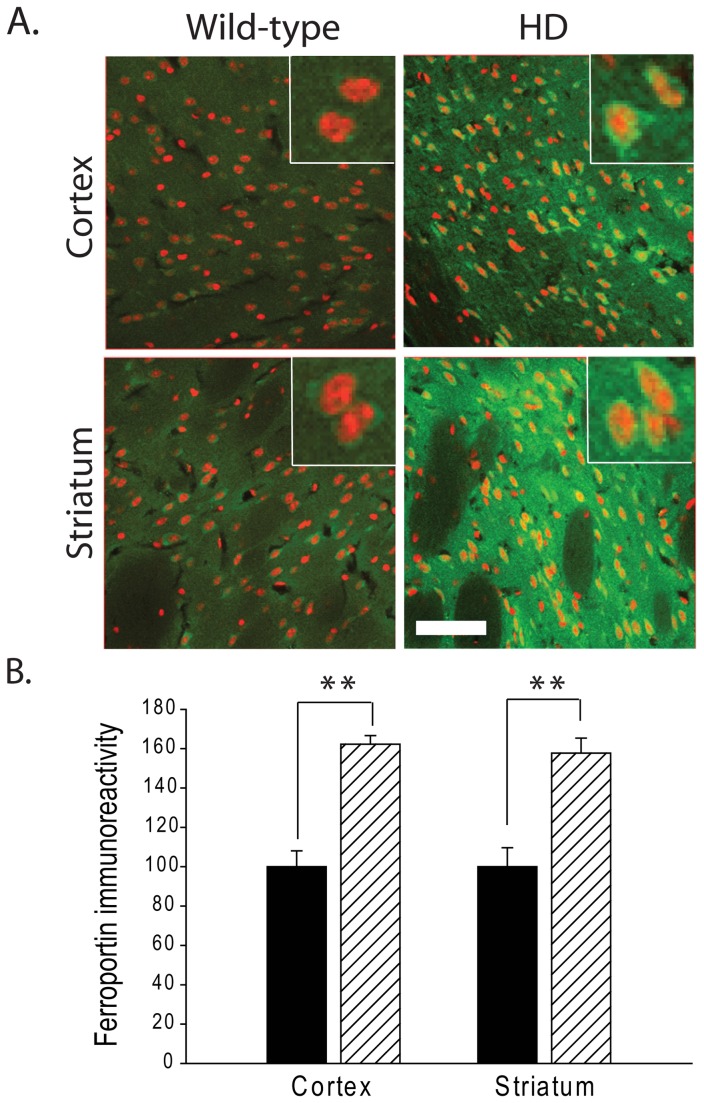
Increased expression of ferroportin (FPN) in R6/2 HD mice.
A. FPN immunoreactivity is increased in HD mouse cortical and striatal neurons as compared to wild-type mice at 12 weeks (red, DRAQ5 stain; green, FPN). Bar = 50 μm. Inserts = 20 μm. B. Quantification of A. FPN immunoreactivity is increased ~0.6 fold in both cortex and striatum of HD mice as compared to WT litter mate mice. P-value: **< 0.01, n=3-4.